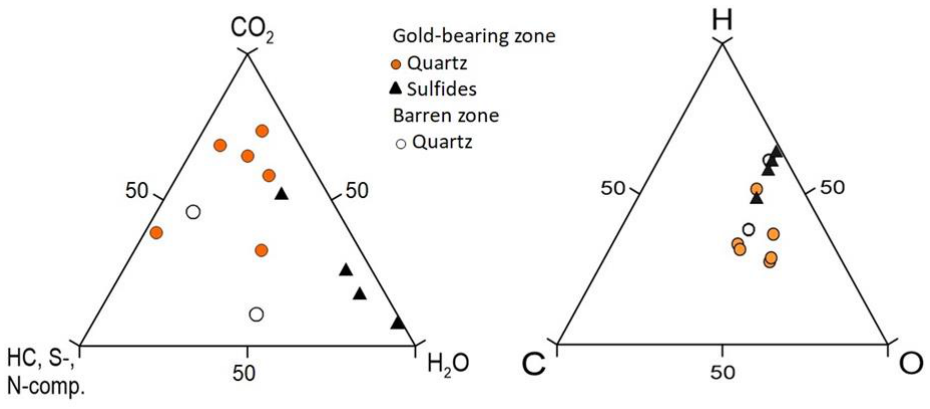
Figure 7. Composition volatiles extracted from fluid inclusions in quartz and sulfides from the Dobroe deposit (GC – MS data).